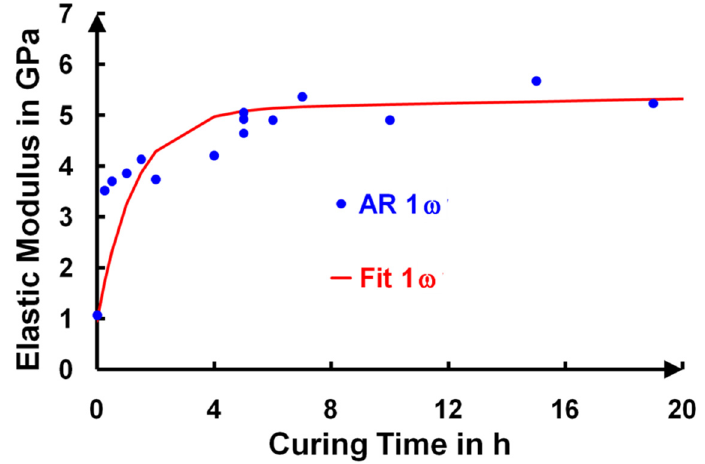
Figure 13. Determination of the elastic modulus (GPa) versus the curing time for AR 1 layers.